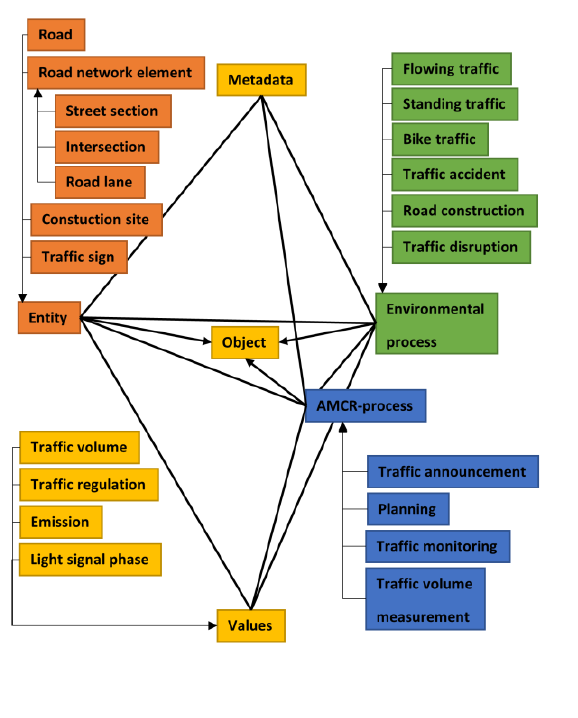
Figure 3: Road network in